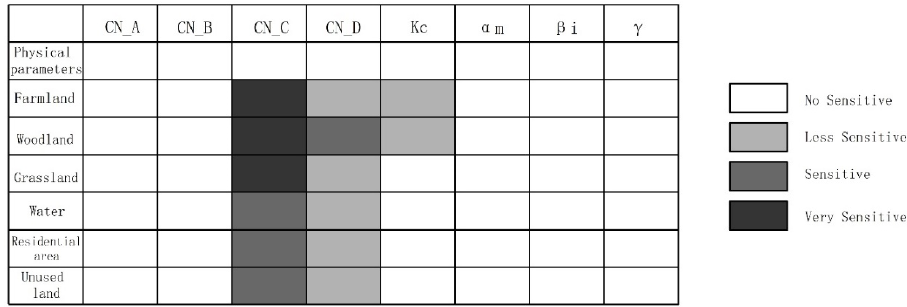
Figure 3. Model parameter sensitivity analysis results.